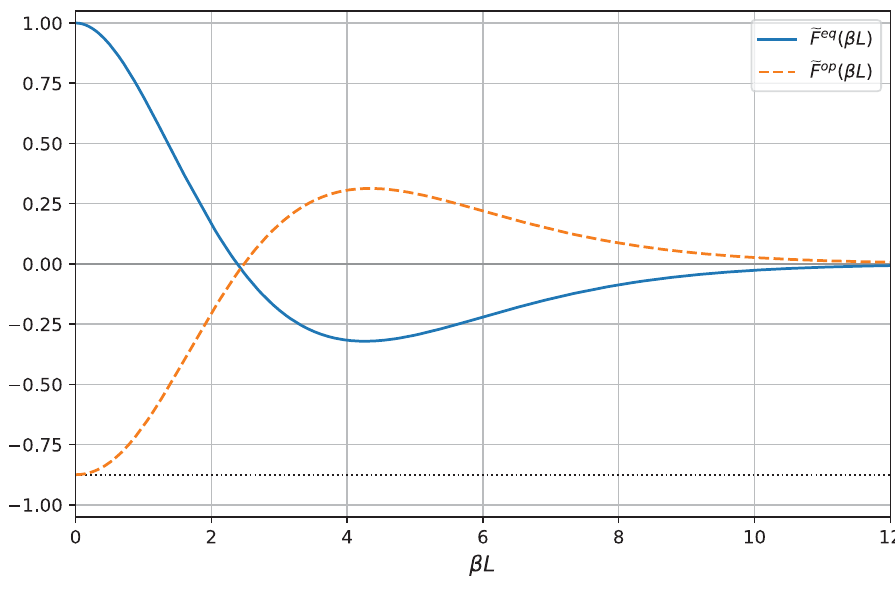
Figure 1. The Casimir force in a chiral medium relative to the QED Casimir force for the cases when α + = α − ( dashed horizontal line corresponds to − 7